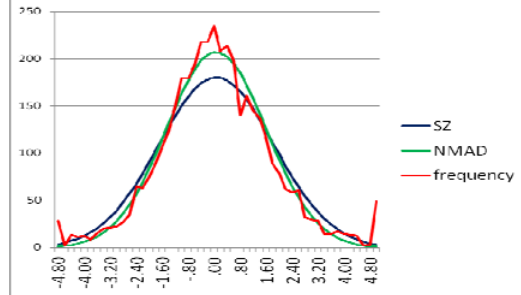
Figure 10. Frequency distribution of the height model based on all 3 images together against reference DTM